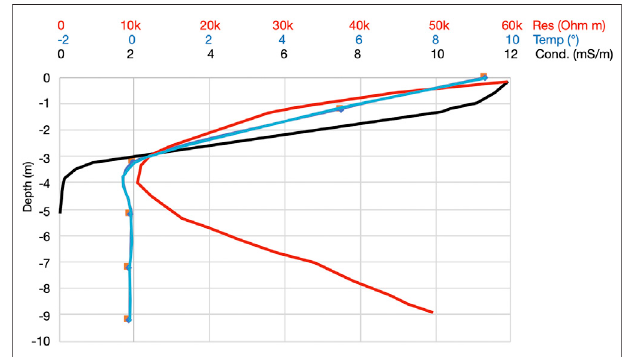
FIGURE 7 | Vertical plots at borehole B2 for: ERT resistivities (red line), FDEM conductivity (black line) and borehole temperatures (blue line).